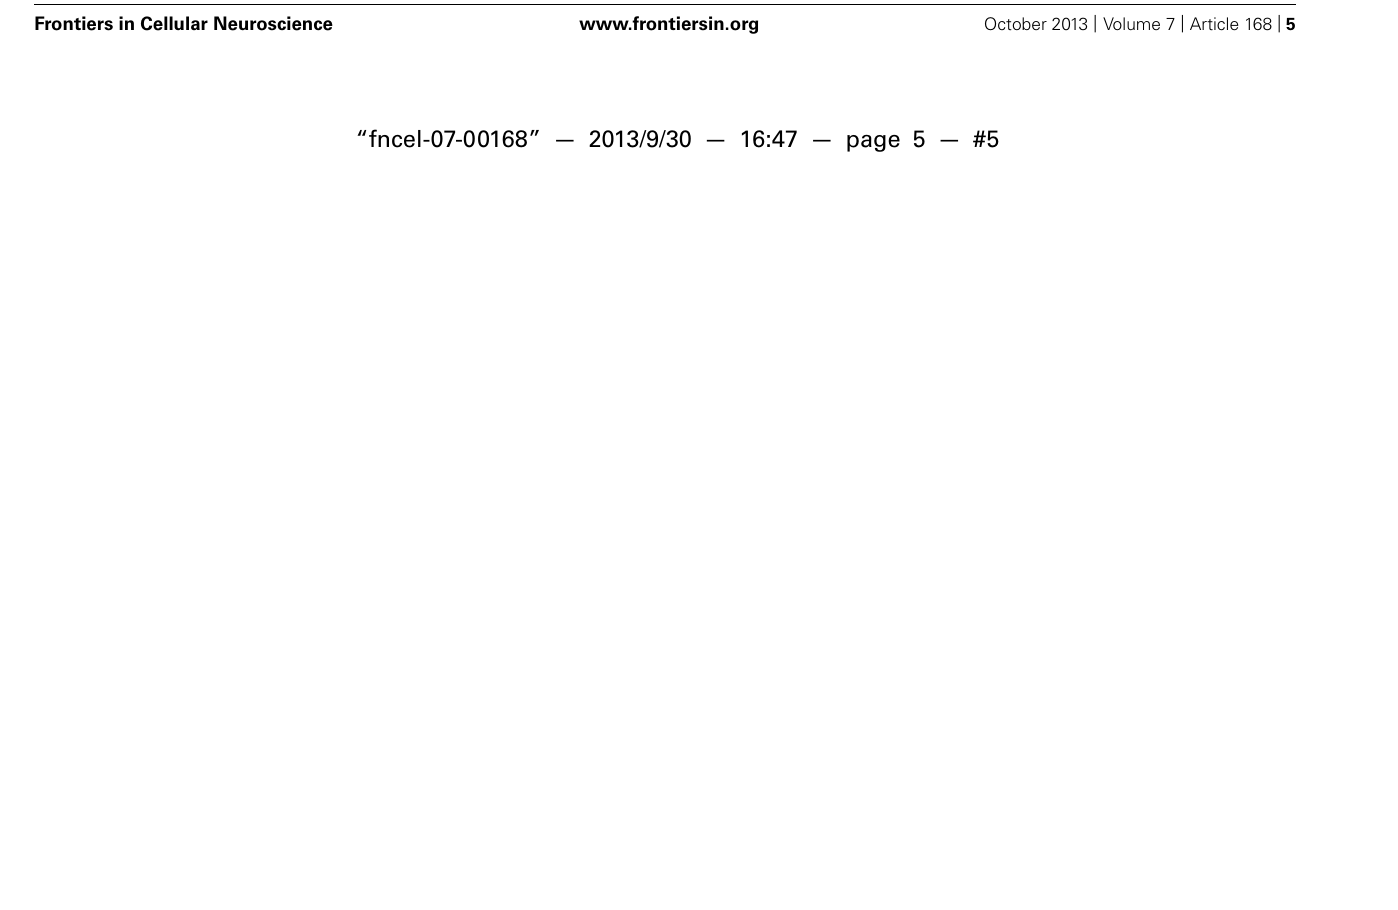
FIGURE 1 | Different mechanistic action of lncRNAs that overlap an mRNA target . (A) lncRNA expressed from the antisense strand may have an overlapping domain, providing specificity, and a non-overlapping activation domain.This activation domain could be a sequence that allows single-strand